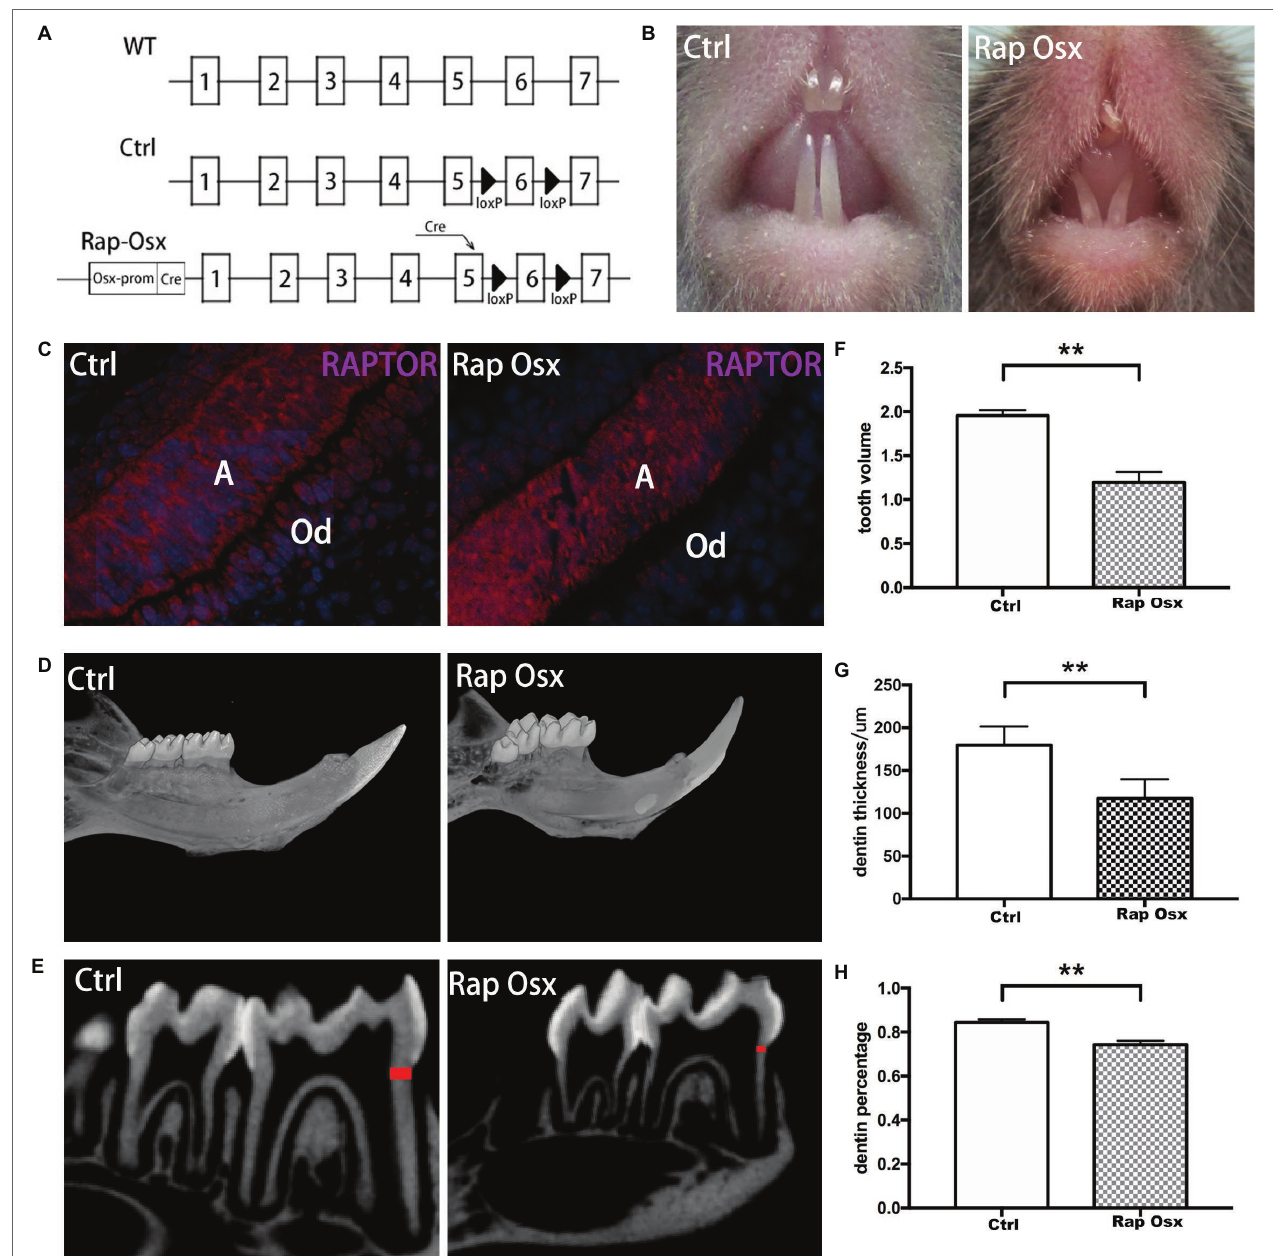
FIGURE 1 | Conditional knockout of Raptor resulted in defects in dentinogenesis. (A) Diagram of the breeding strategy used to obtain Osx-Cre mice with mediated homozygous deletion of Raptor (Rap-Osx) (WT: wild-type mouse; Ctrl: WT mouse with exon 6 flanked by two LoxP sites; white tile: exon; black arrowhead: LoxP site). (B,C) Immunostaining of the Raptor protein in odontoblasts/preodontoblasts of the Ctrl and Rap-Osx mice, respectively. (D) 3D reconstruction of the mandible and molars of the Ctrl and knockout mice. (E) Sagittal section of micro-CT scanning of the lower first molars of Ctrl and Rap-Osx mice; the dentin, labeled in red, was used for dentin thickness analysis. (F–H) Statistical analysis of the tooth volume, dentin thickness and dentin percentage of the Ctrl and knockout mice. Data represent the mean ± SD (** p < 0.001). A, ameloblasts; Od,